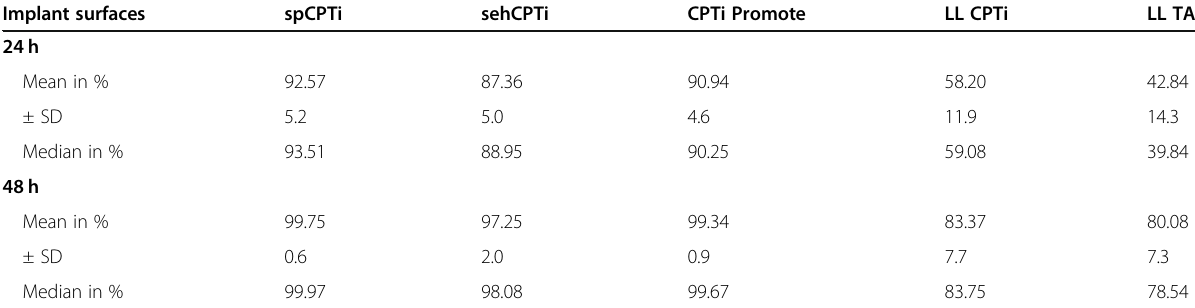
Table 1 Overview on mean initial plaque area ± standard deviations as well as medians regarding the groups Implant surfaces